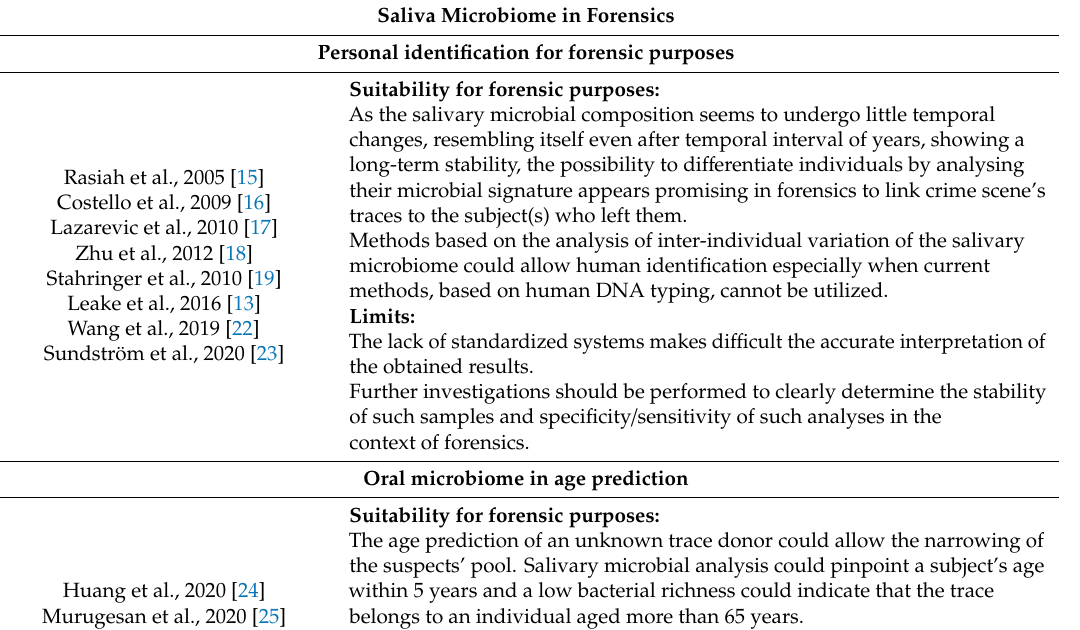
Table 1. Potentials and limitations for forensic purposes of oral microbiome, considering the four categories: (a) personal identification for forensic purposes; (b) oral microbiome in age prediction; (c)signatureofethnicityinoralmicrobiome;